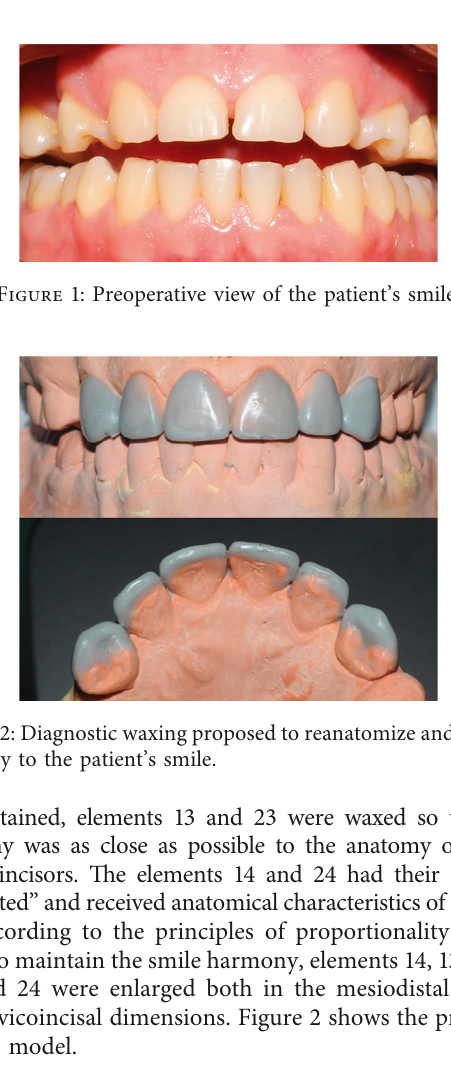
A3/Final color: A2-VITA Classical scale).